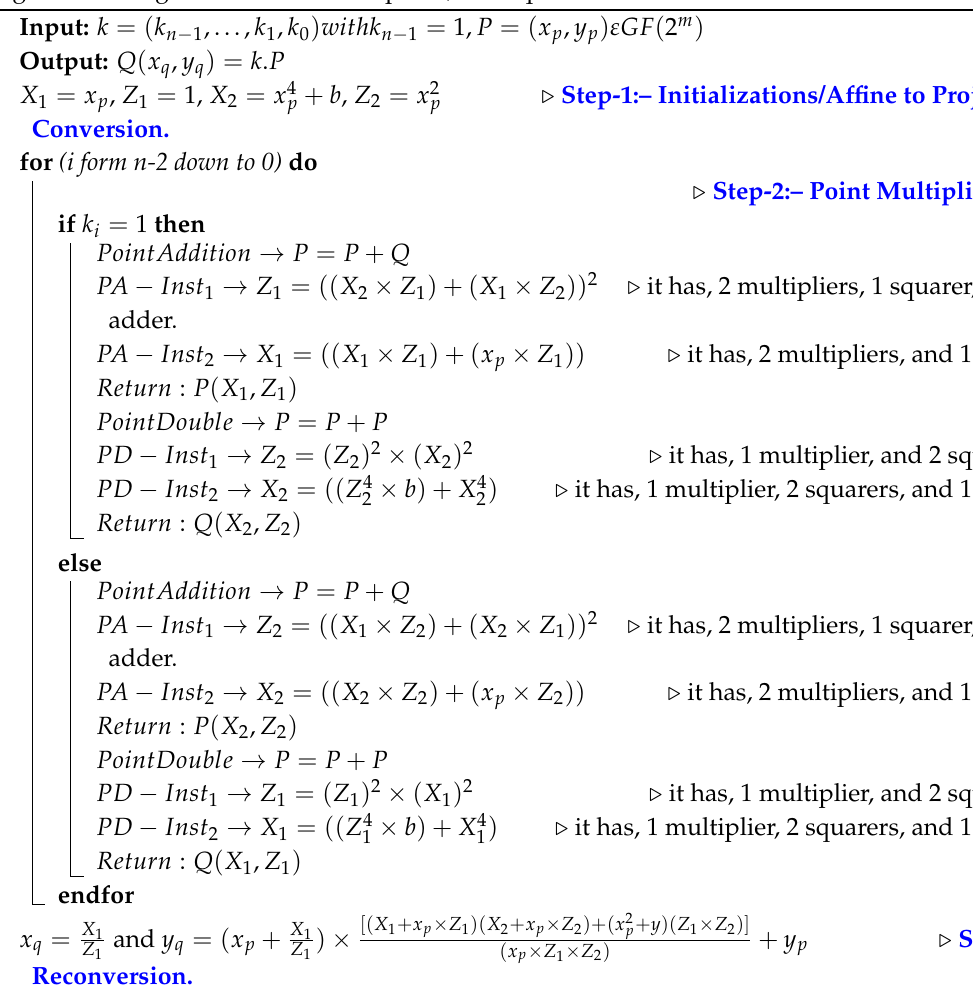
Algorithm 2: Proposed instructions parallelization for PM computation of Montgomery algorithm using two modular multipliers, two squarers and an adder